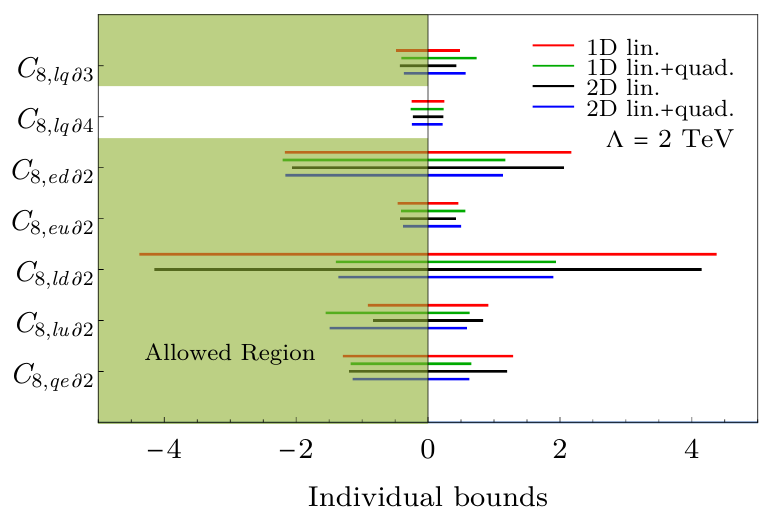
Figure 3 . Individual bounds on the dimension-8 coefficients for Λ = 2 TeV. 95% confidence intervals are given at both the linear and quadratic levels and obtained with either the 1D or 2D differential B 0 analyses, see text for details. “Allowed Region” indicates the elastic positivity bounds of table 1. Coeff.